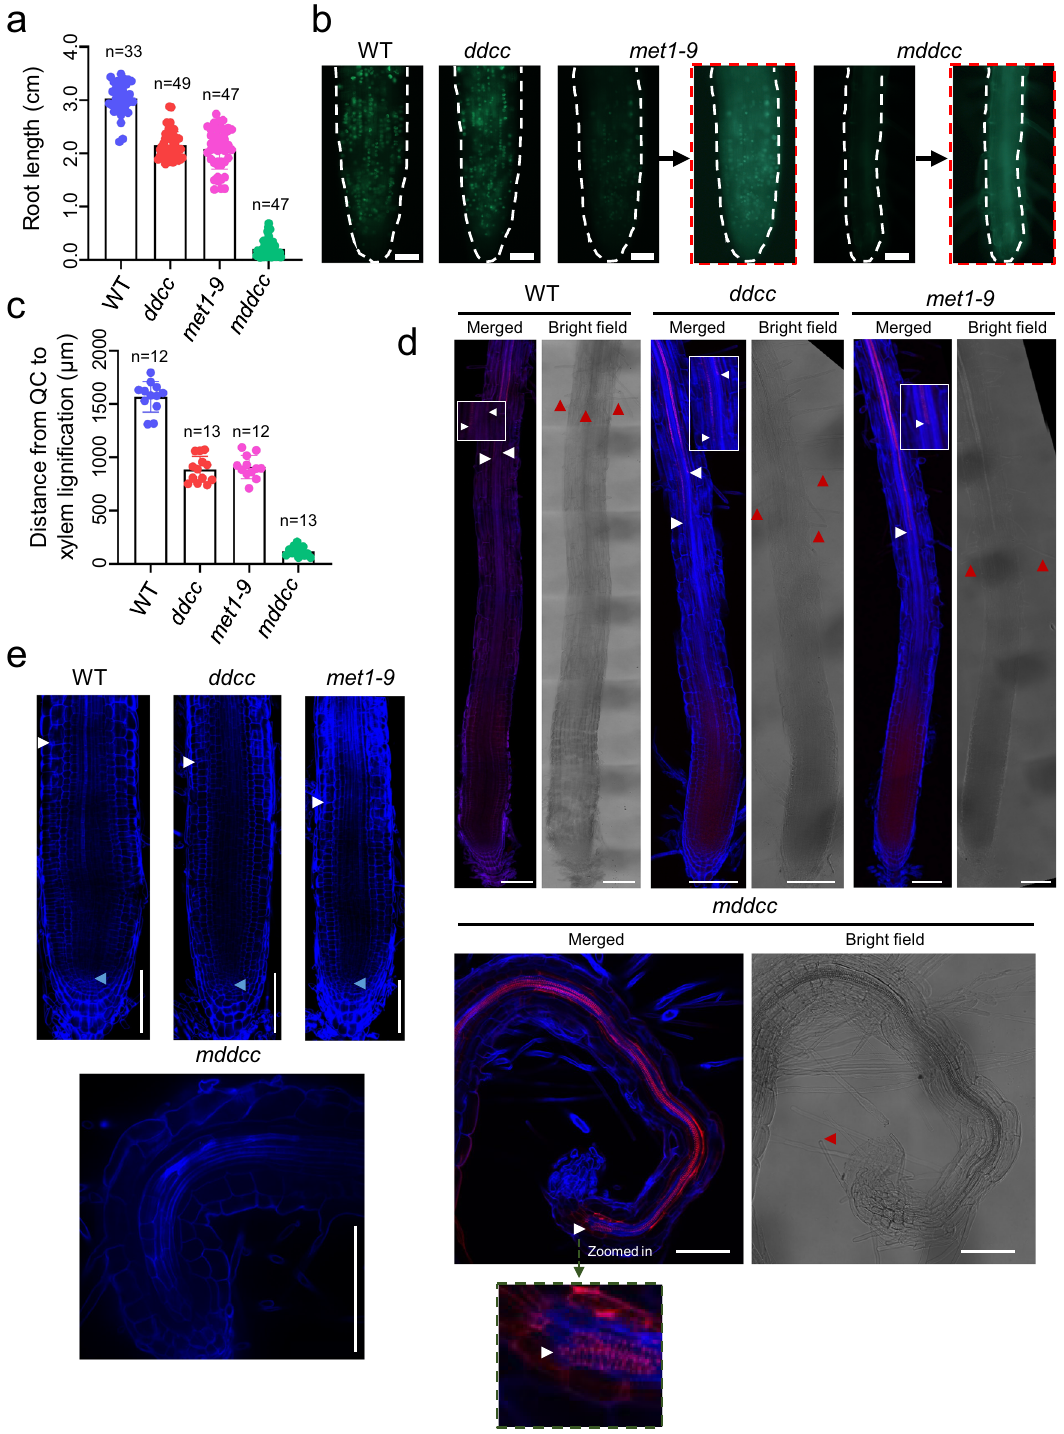
Fig. 6 CG and non-CG methylation jointly regulate the activity of RAM. a Quanti fi cation of root length of 9-day-old WT, ddcc , met1-9 , and mddcc seedlings. The data are the means± SD of the biological repeats. b Representative images of EdU labeling in the RAM of roots of 11-day-old WT, ddcc , met1- 9 , and mddcc seedlings. Images framed with a red dotted line show a higher exposure version of the images on the left. Scale bar: 50 μ m. Experiments were independently repeated two times with similar results. c Distance from the QC to xylem ligni fi cation in roots of 9-day-old WT, ddcc , met1-9 , and mddcc mutants. The data are the means ± SD of the biological repeats. d Cleared roots stained with calco fl uor white (blue) and basic fuchsin (red). White arrowheads indicate the site of appearance of the fi rst protoxylem cells; red arrowheads indicate root hairs. Scale bar: 100 μ m. Experiments were independently repeated two times with similar results. e Representative images of root meristems from 9-day-old WT, ddcc , met1-9 , and mddcc seedlings. Cell outlines were visualized with calco fl uor white. Blue and white arrowheads indicate the QC and the cortex transition boundary, respectively. Scale bars: 100 μ m. Experiments were independently repeated two times with similar results. Source data are provided as a Source Data fi